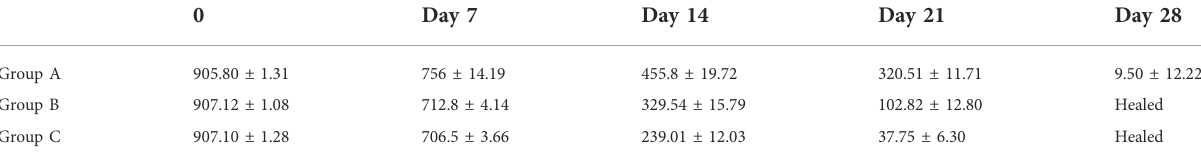
TABLE 1 Mean ± SE of total wound area (mm 2 ) of skin wounds in rabbits of Groups A, B, and C at Days 0, 7, 14, 21, and